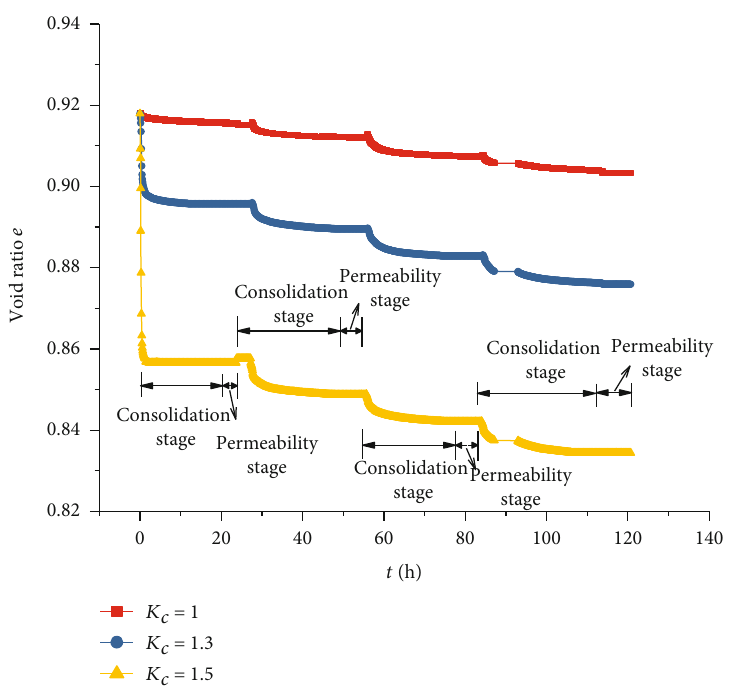
Figure 7: The curve of void ratio of normally consolidation clay with